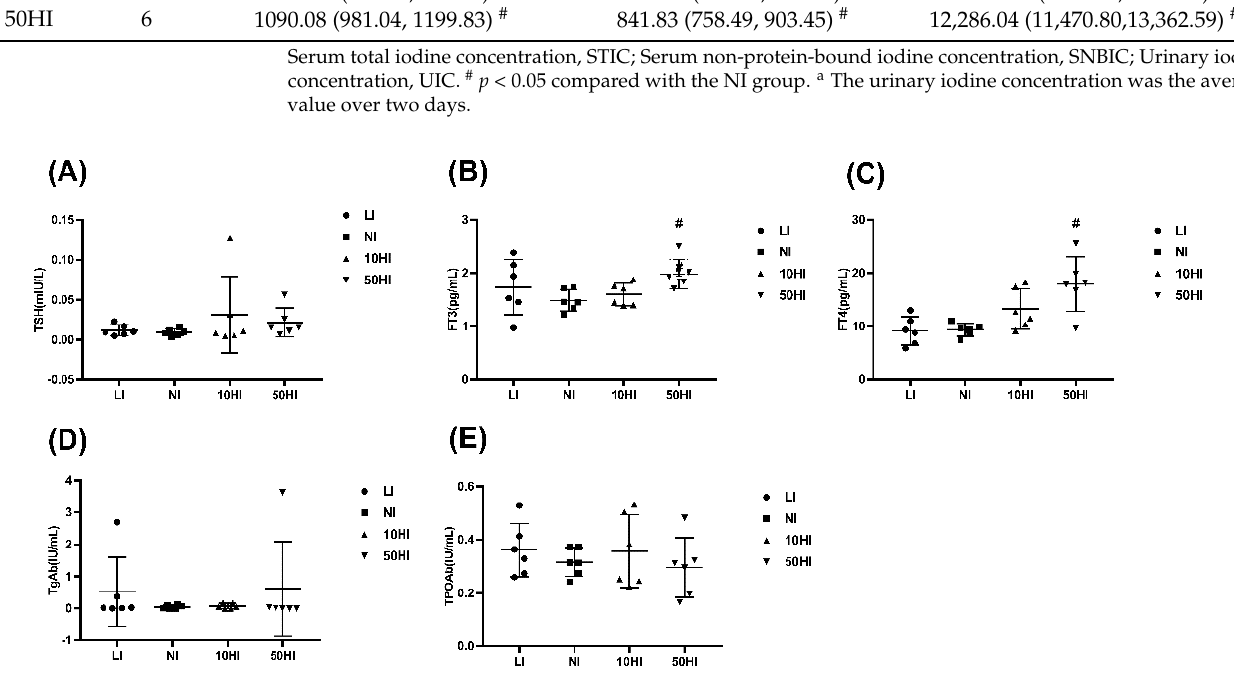
Figure 1. Serum concentrations of TSH ( A ), FT3 ( B ), FT4 ( C ), TgAb ( D ), and TPOAb ( E ) in lactating rats. Free triiodothyronine, FT3; Free thyroxine, FT4; Thyroid − stimulating hormone, TSH; Thyroid peroxidase antibody, TPOAb; Thyroglobulin antibody, TgAb. # p < 0.05 compared with the NI